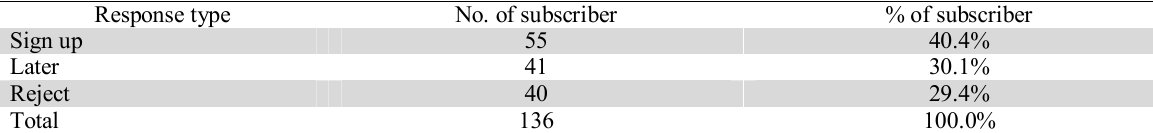
The result of subscriber